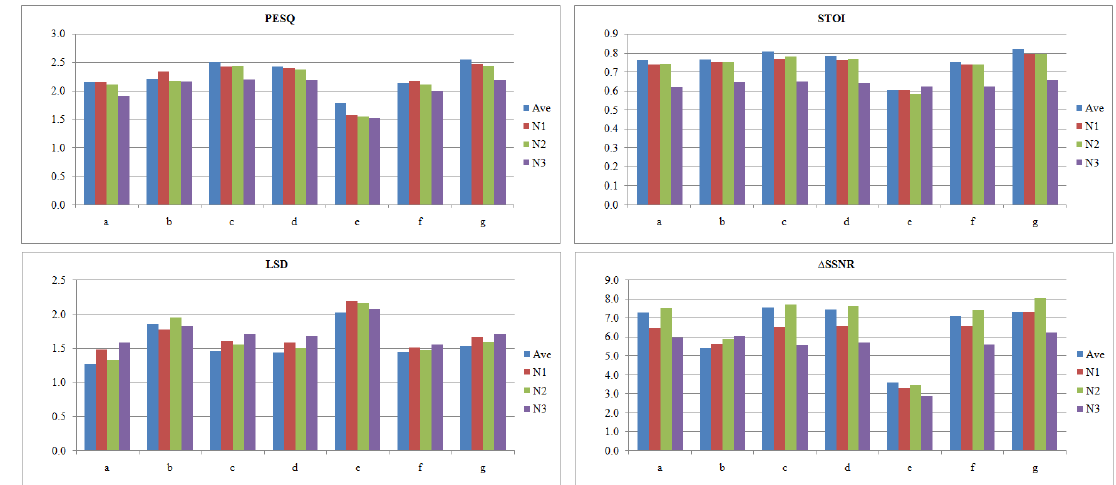
Figure 6. PESQ, STOI, LSD, and ∆ SSNR results for three challenging noise environments: babble noise, N1; two background noises, N2; and reverberation, N3; compared to the average of seen and unseen noise shown in Table 3,